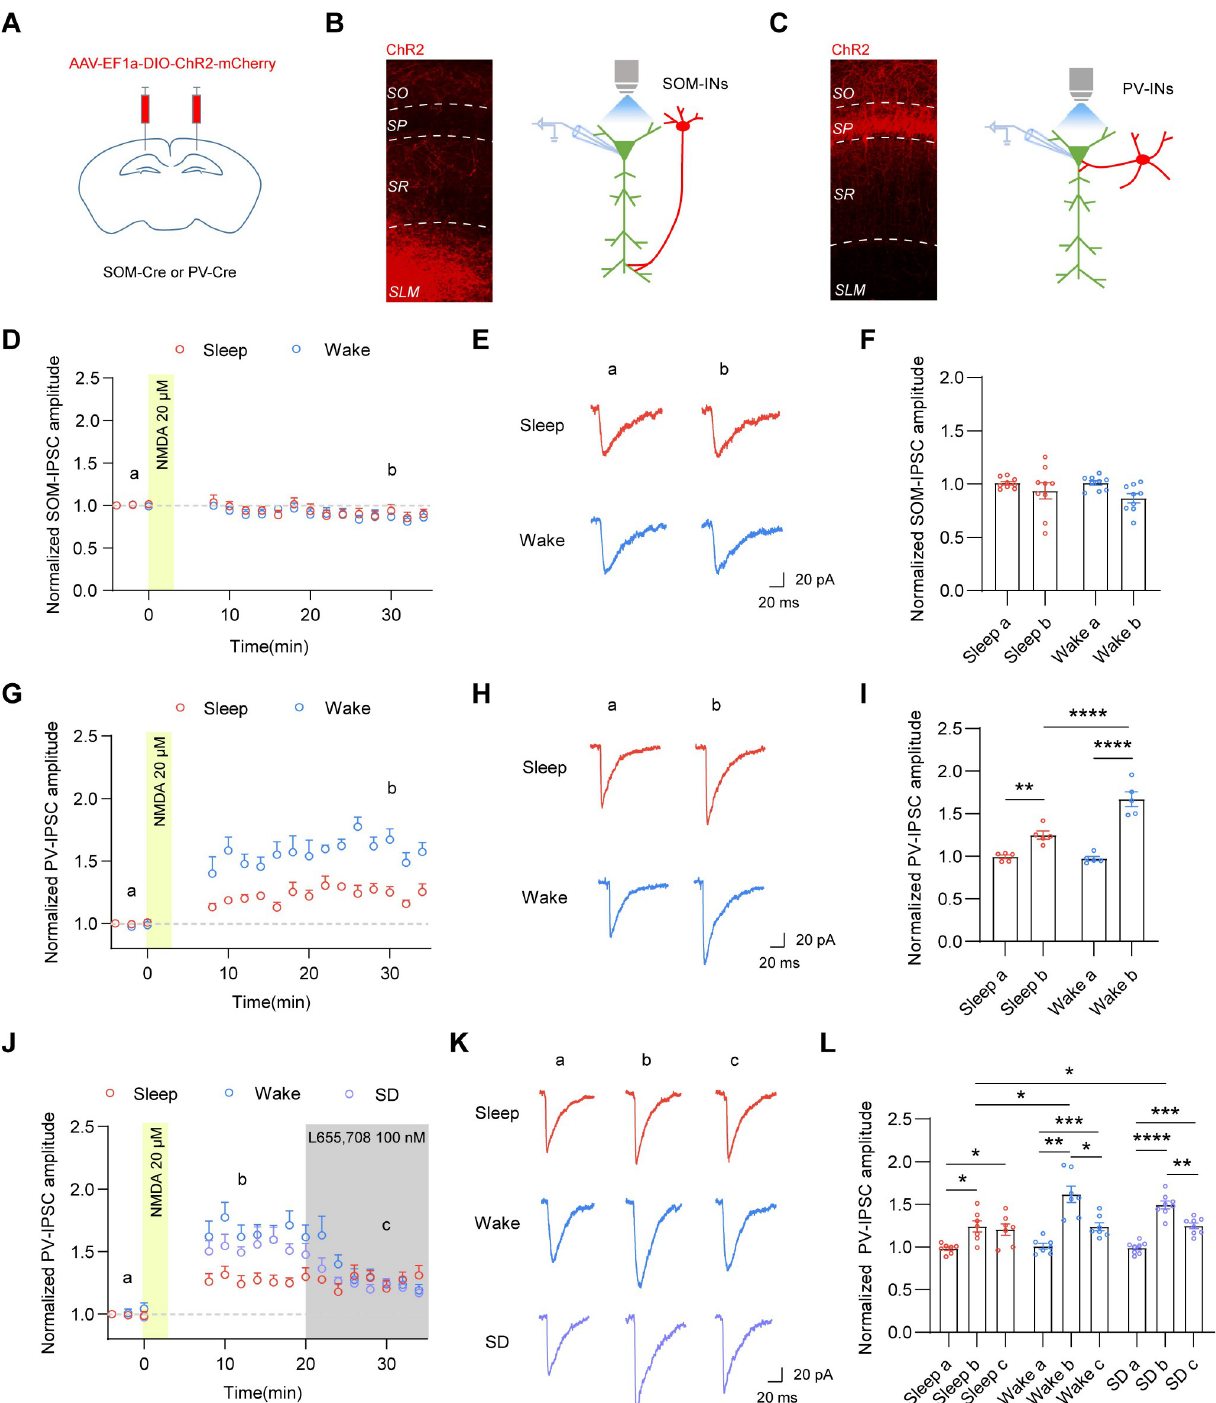
Fig 4. Recruitment of α 5-GABA A Rs to PV-synapses contributes to wake-dependent enhancement of iLTP. (A) Scheme of the injection of AAV-EF1a-DIO-ChR2-mCherry into the hippocampal CA1 region of SOM-IRES-Cre or PV-IRES-Cre mice. (B, C) Left: Fluorescence image showing ChR2 expression in different hippocampal layers of SOM-IRES-Cre (B) or PV-IRES-Cre mice (C). SO, stratum oriens; SP, stratum pyramidale; SR, stratum radiatum; SLM, stratum lacunosum-moleculare. Right: Schematic displaying the recording set up for iLTP experiments. (D) Time course of IPSCs in hippocampal CA1 pyramidal cells evoked by photo-activation of SOM-INs (SOM-IPSCs) before and after NMDA application. The data were binned into 2-min time bins. (E) Representative SOM-IPSC traces at indicated time points in (D). (F) There were no changes of SOM-IPSC amplitude before and after NMDA application in sleep and wake mice ( n = 9, 2-way ANOVA with Sidak’s multiple comparison test). (G) Time course of IPSCs in